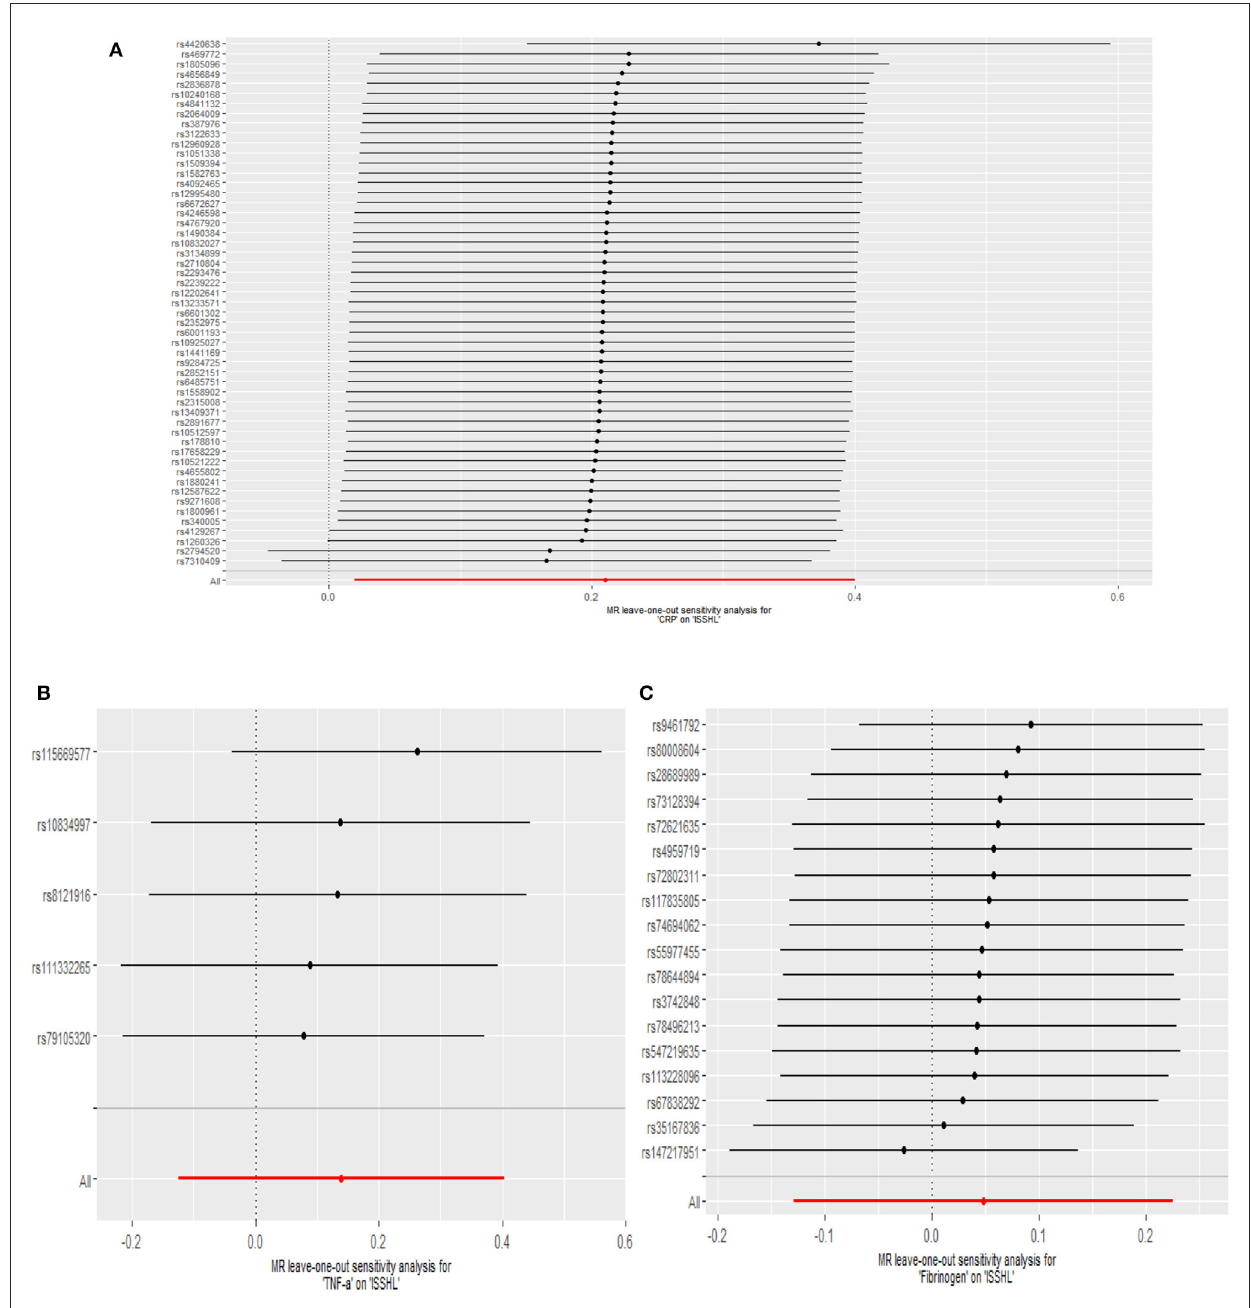
FIGURE4 Leave-one-out plots for the MR analyses of ISSHL on CRP (A) , TNF- α (B) , and Fibrinogen (C) .